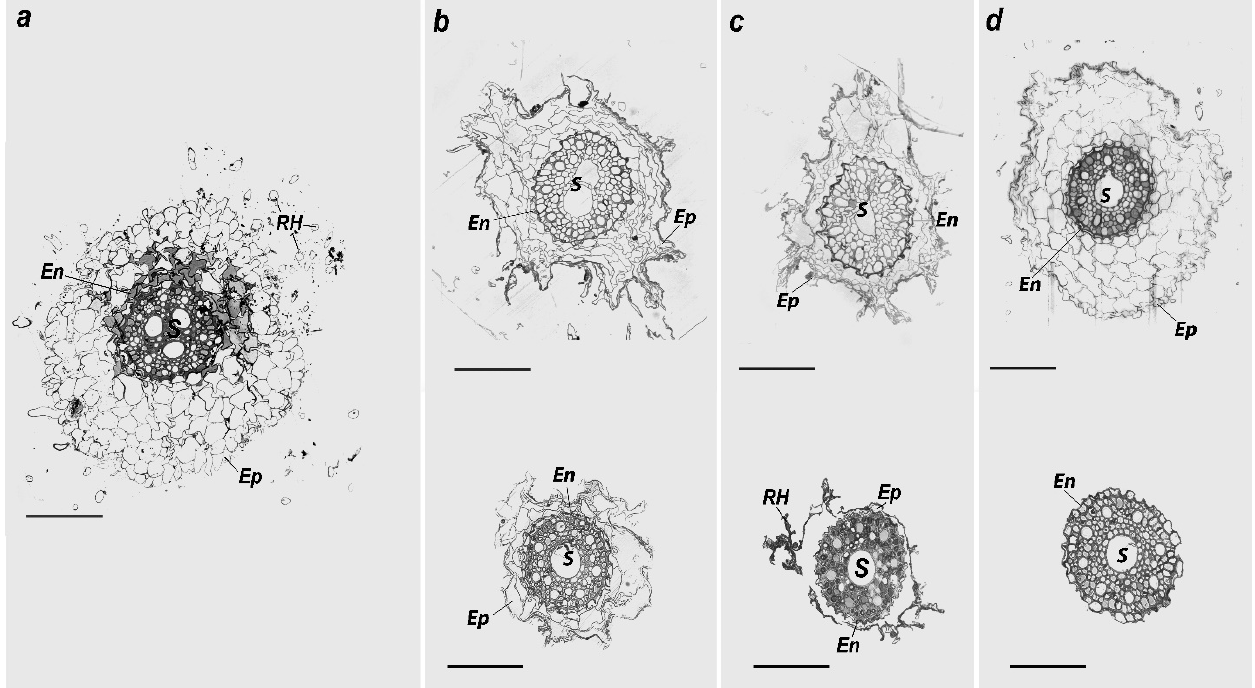
Figure 2. Effects on morphological characteristics of H. vulgare in different treatments of the model experiment, cm .